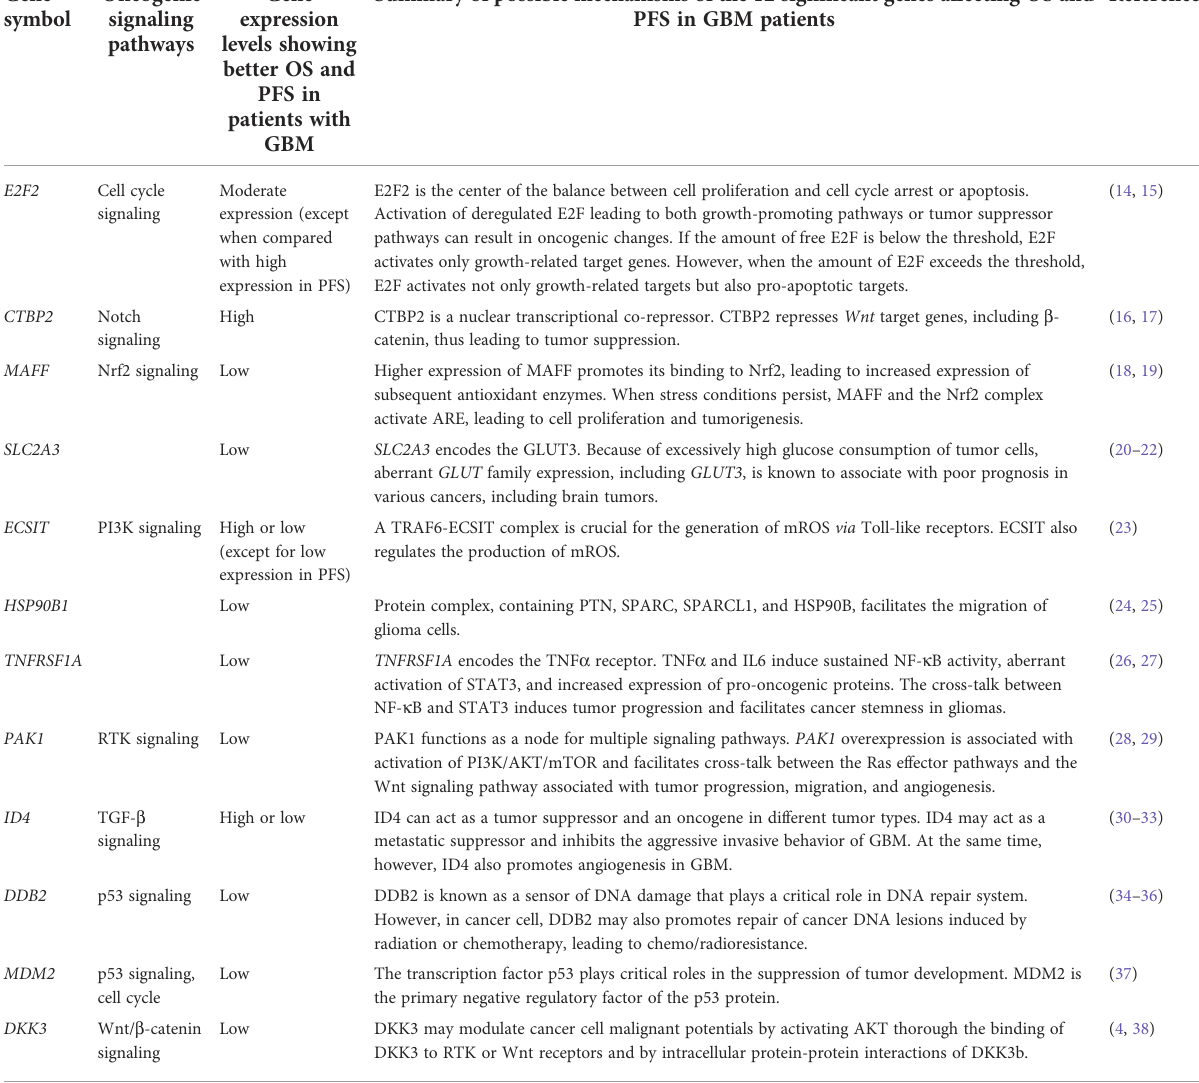
TABLE 3 Detailed information of the 12 genes from the 10 oncogenic signaling pathways, which are signi fi cantly associated with overall survival and progression-free survival in patients with GBM.